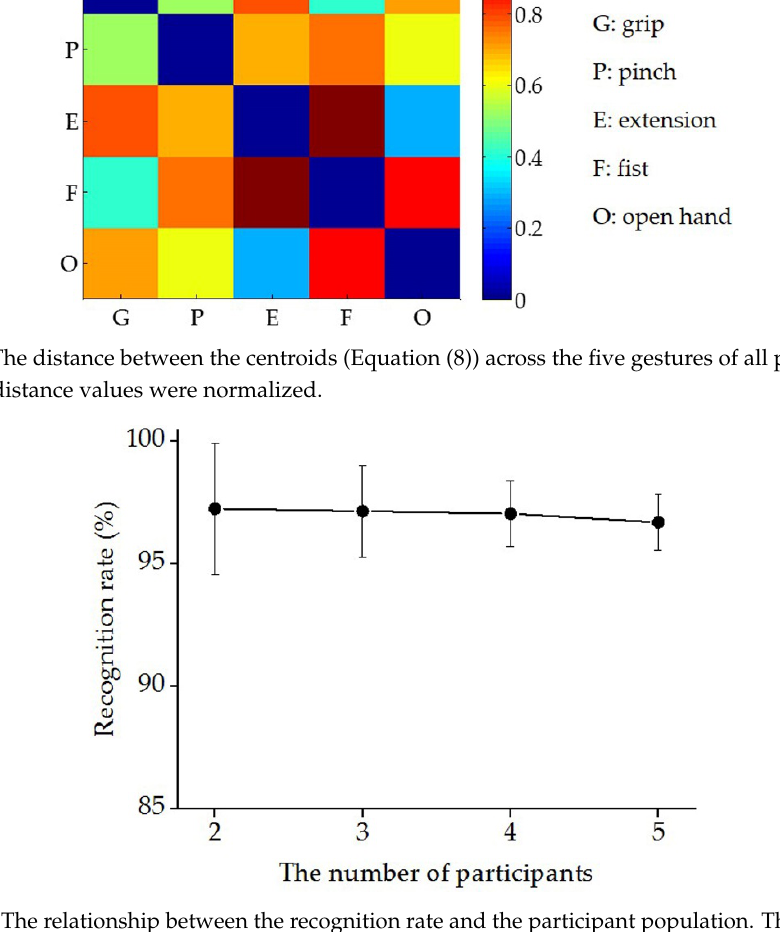
Figure 10. The relationship between the recognition rate and the participant population. The extracted feature data were pooled and divided into a corresponding training set and test set. The recognition rate was calculated through a support vector machine (SVM) classifier with 5-fold cross-validation. All combinations of the participants were considered.